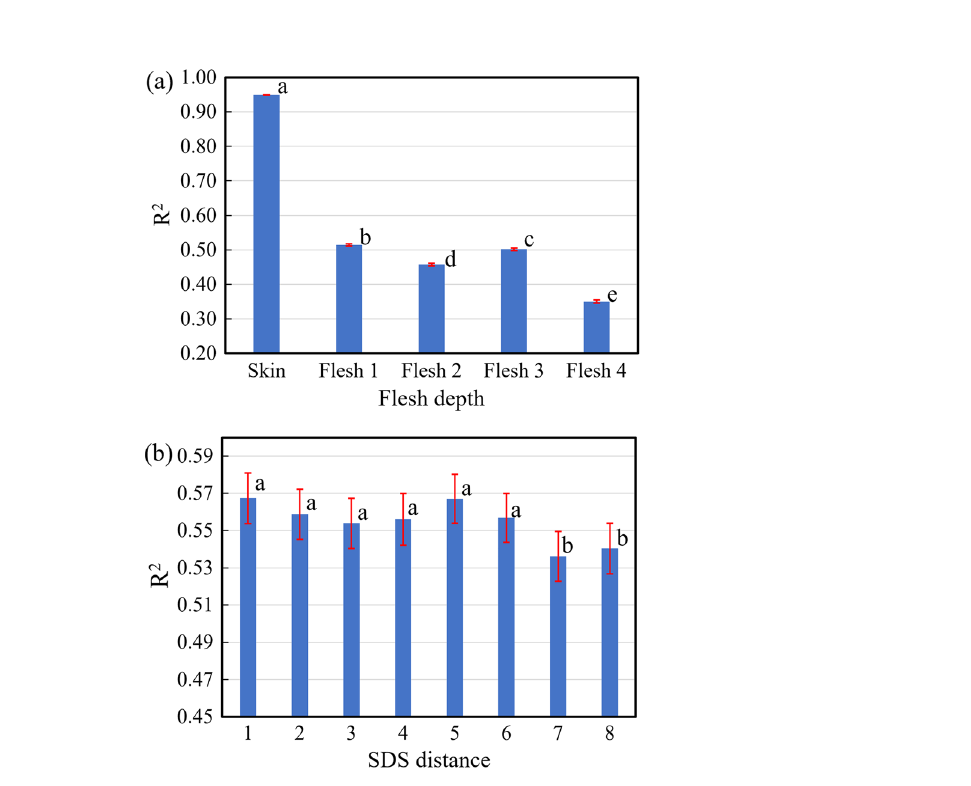
Figure 6. Average (± SE) R 2 for PLS models based on different flesh depths ( a ) and SDS distances ( b ). Flesh depth significantly influenced the prediction accuracy ( p < 0.001). Significant differences were observed between short (1 through 6) and longer (7–8) detector distances ( p <